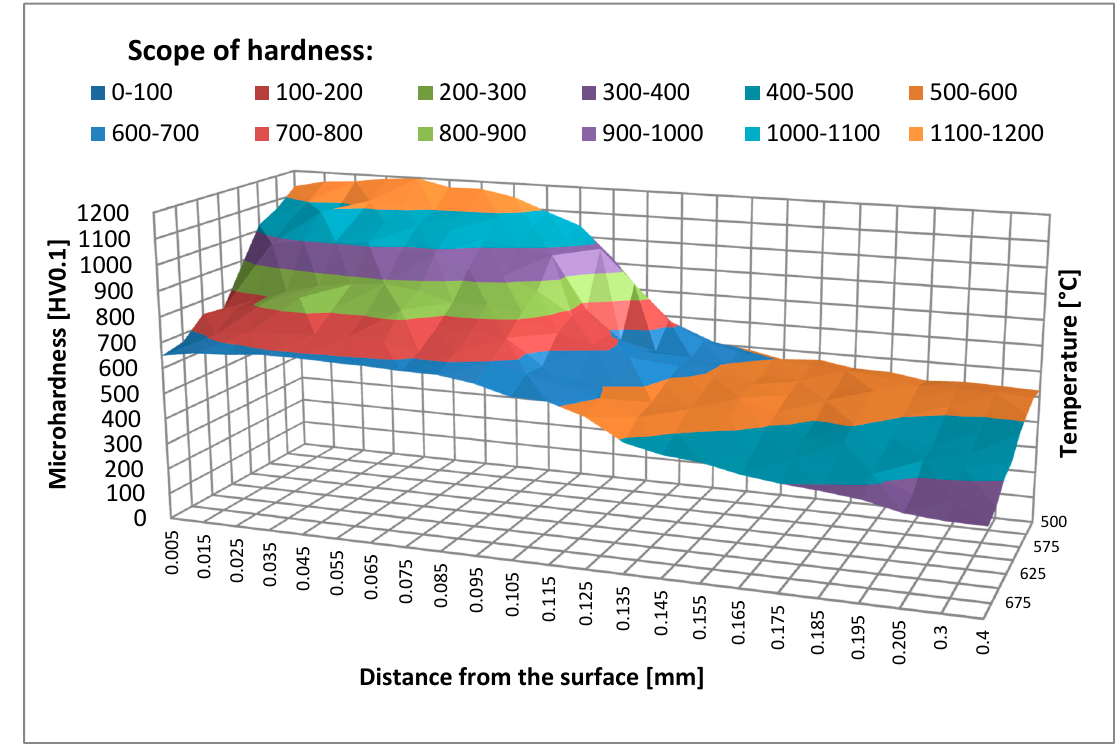
Figure 3. Hardness in the surface layer of samples after annealing for 2 h as a function of the distance from the surface.